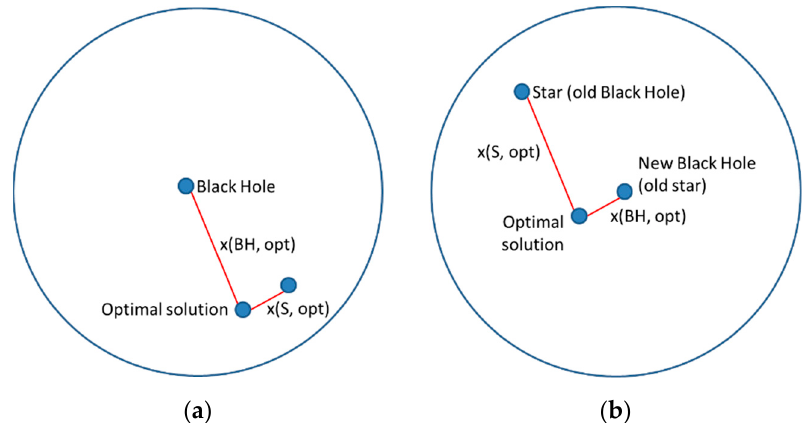
Figure 8. The scheduling of the evaluation of stars inside the Schwarzschild radius influences the convergence speed of the algorithm: ( a ) If the stars inside the event horizon are not evaluated before absorbed, then the distance between optimal solution inside the event horizon and the black hole should be higher than the distance between the optimal solution and the star; ( b ) If the star inside the event horizon is evaluated, then the star with a better value of objective function could become the new black hole, while the old black hole becomes a star.